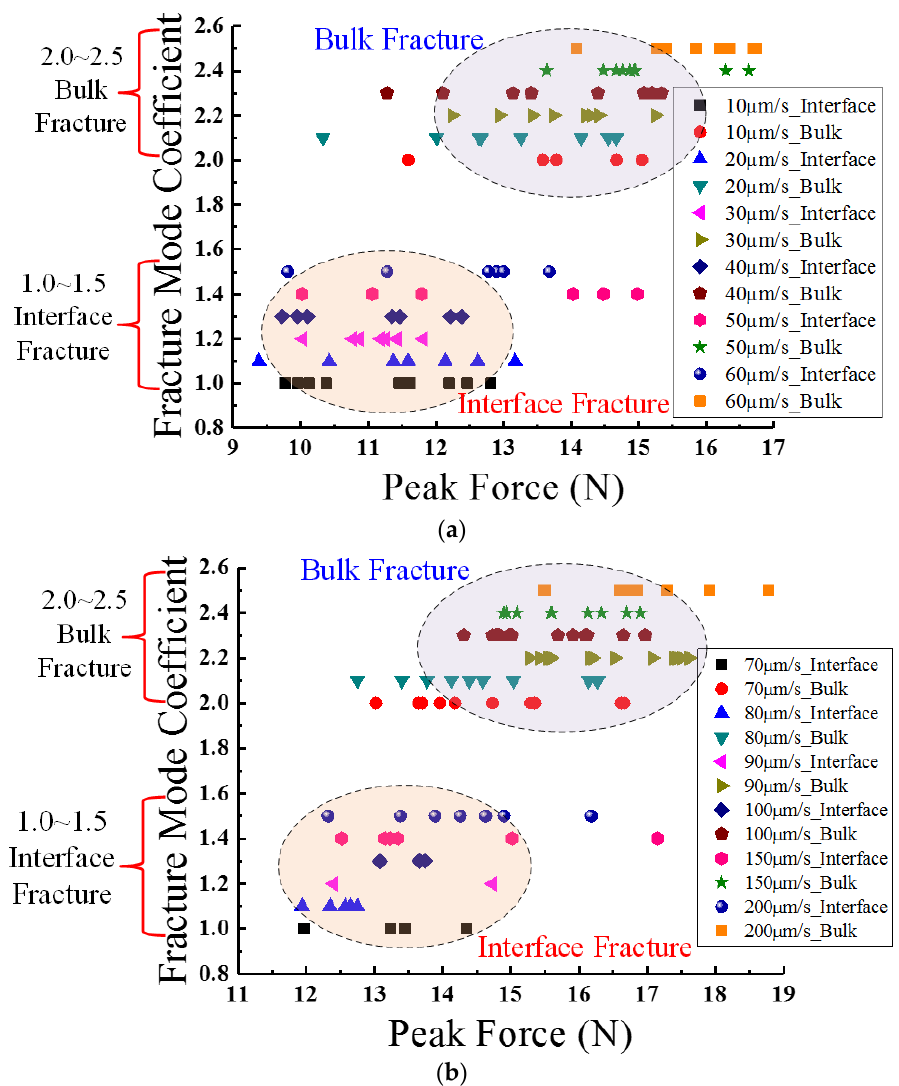
Figure 8. Statistical analysis results of peak force values according to the difference in fracture mode: ( a ) shear rates from 10 to 60 μ m/s; ( b ) shear rates from 70 to 200 μ m/s.